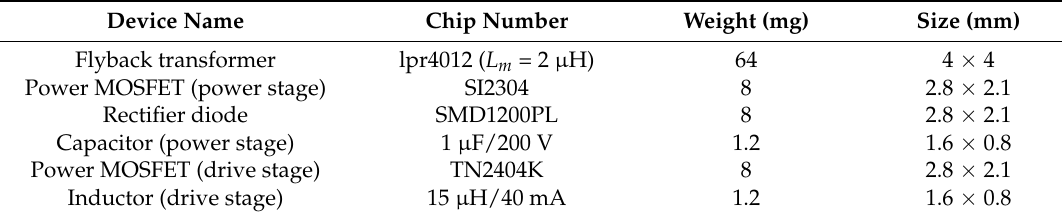
Table 3. Specifications of the discrete components.